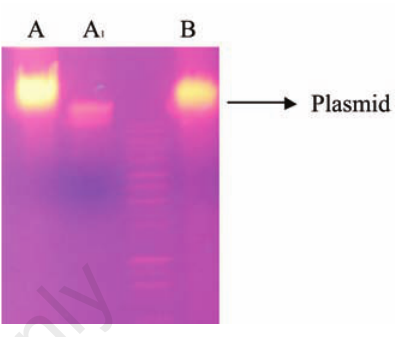
Figure 1. Electrophoretic separation pro- files of plasmids from cured and non-cured strains. Lane A: Corynebacterium sp ; Lane A1: cured Corynebacterium sp ; Lane B: Burkholderia cepacia